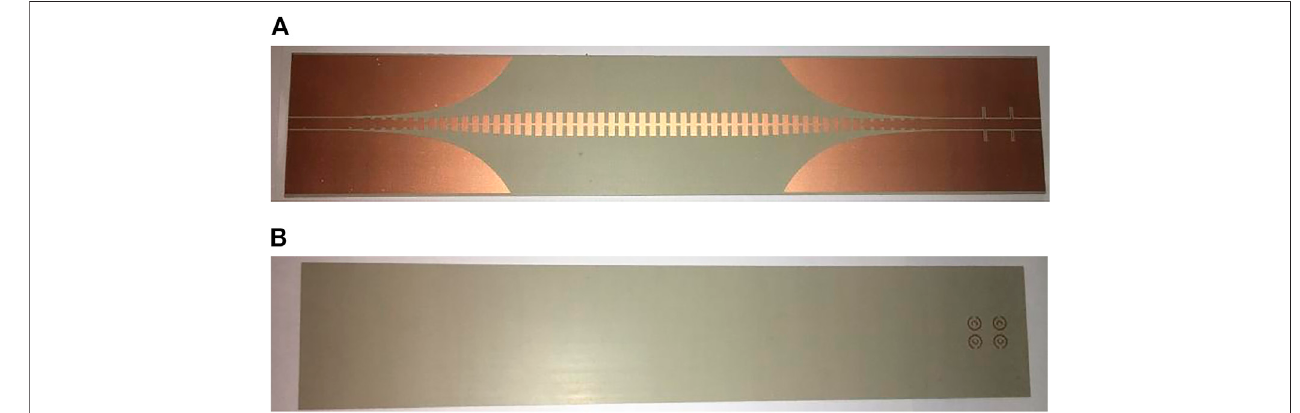
FIGURE 9 | The SSPP fi lter (A) front side (B) reverse side.